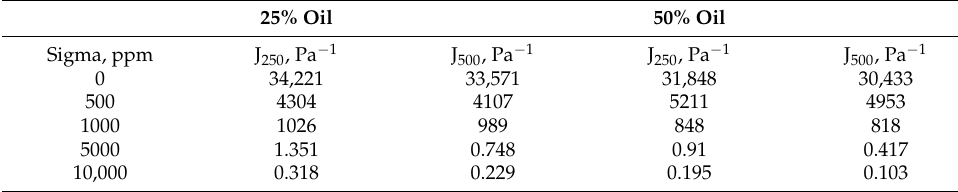
Table 1. Compliance measurements at the end of creep and recovery